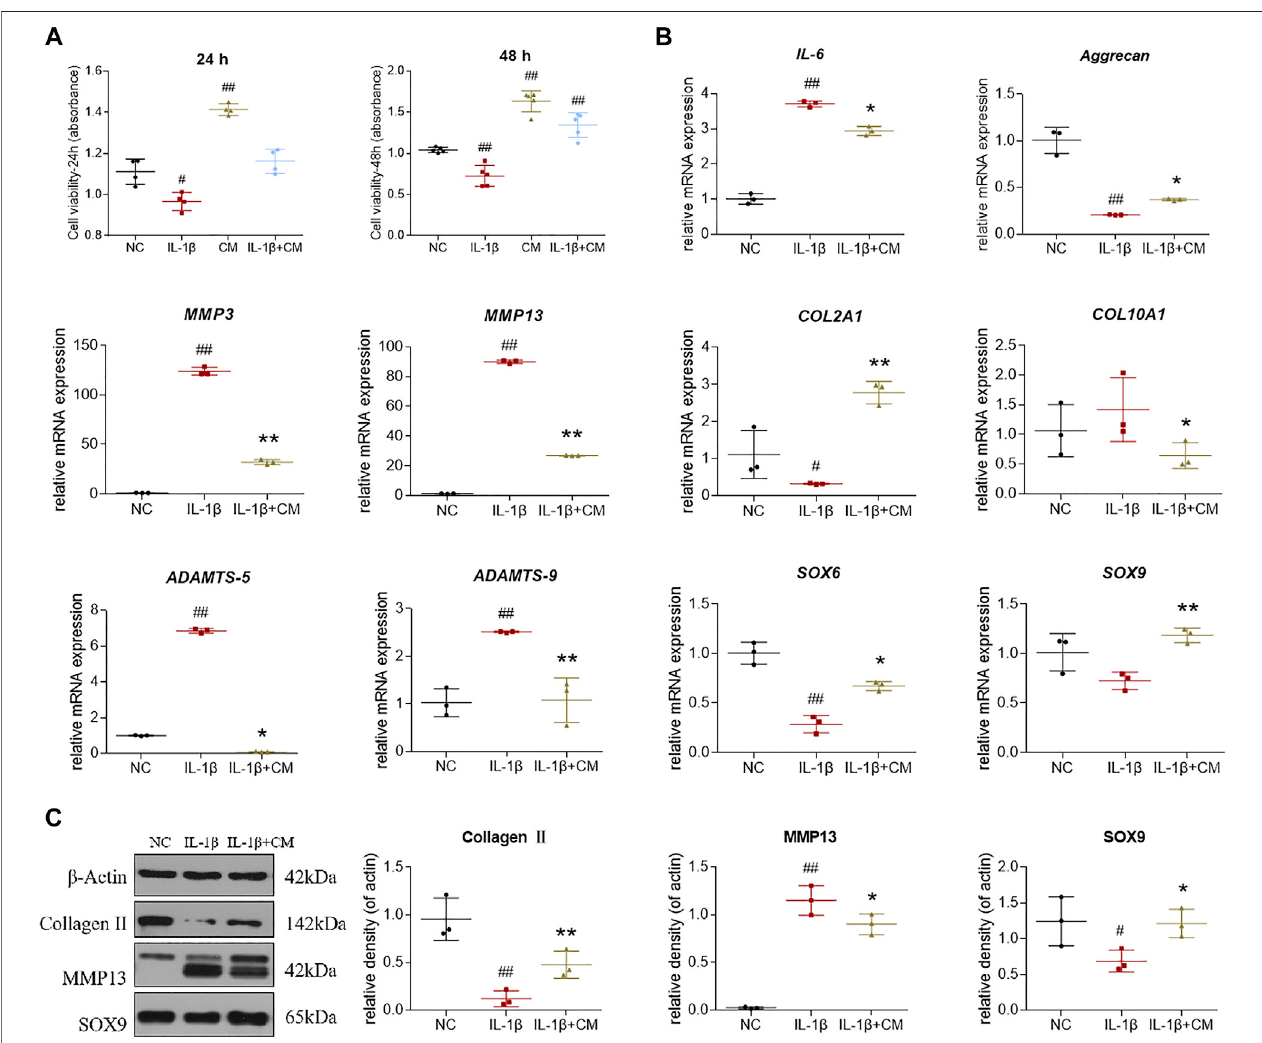
FIGURE 5 | Effects of ADSCs-CM on cell viability and regulations of ADSCs-CM on IL-1 β -treated chondrocytes. (A) Chondrocyte viability at 24 and 48 h after ADSCs-CM treatment; (B) qPCR analysis of mRNA expressions of chondrocytes treated with ADSCs-CM; (C) Expressions of target proteins in chondrocytes treated with ADSCs-CM. Values were presented as mean ± SD. N = 3. # p < 0.05 and ## p < 0.01 versus control group; * p < 0.05 and ** p < 0.01 versus IL-1 β group.